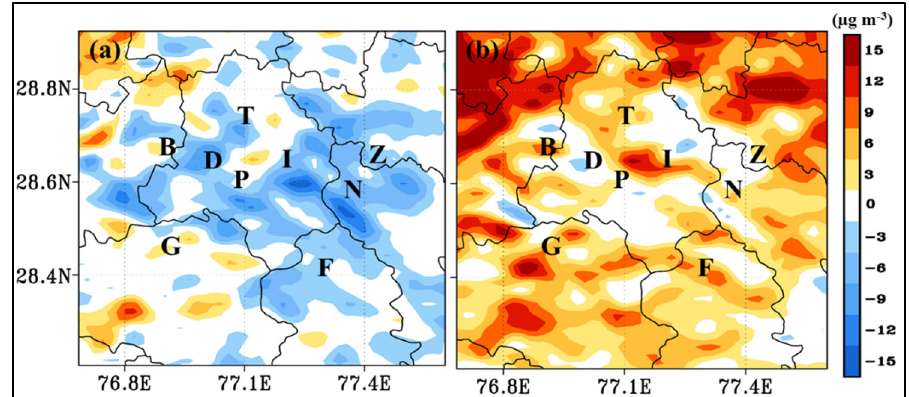
Figure 6. Spatial plots of ( a ) difference of PM 10 concentrations ( µ g m − 3 ) between case with direct feedback and no feedback (Case B—Case A) and ( b ) difference of PM 10 concentrations ( µ g m − 3 ) between case with direct and indirect feedback and no feedback (Case C—Case A) over NCT. (P: Punjabi Bagh, D: Dwarka, I: ITO, T: DTU, N: Noida, Z: Ghaziabad, F: Faridabad, G: Gurugram and B: Bahadurgarh).